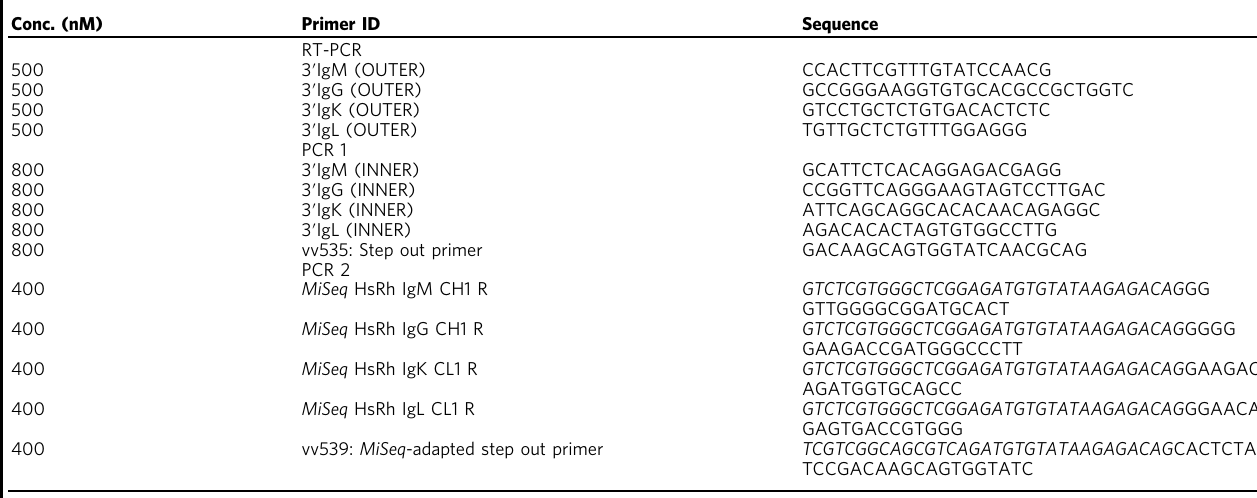
Table 1 Illumina Miseq library preparation primers Conc.